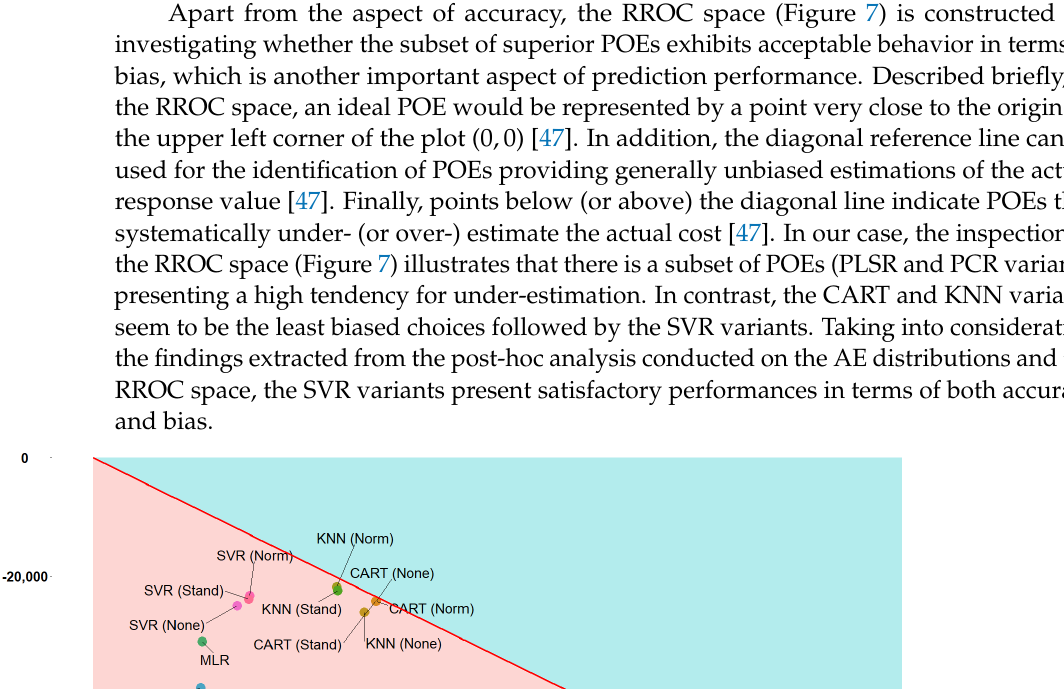
Figure 6. Post-hoc analysis for AE distributions (LMEM on performances of point estimators).